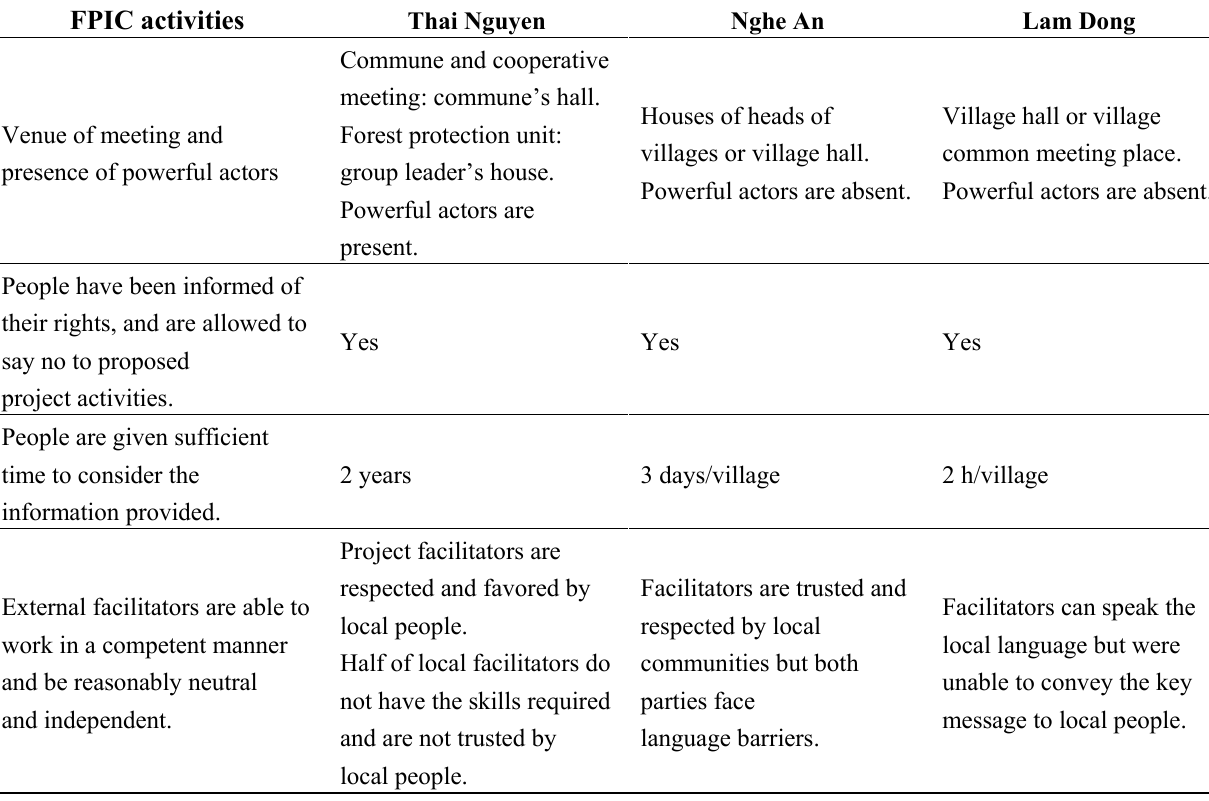
Table 1. Implementation of FPIC in three projects.